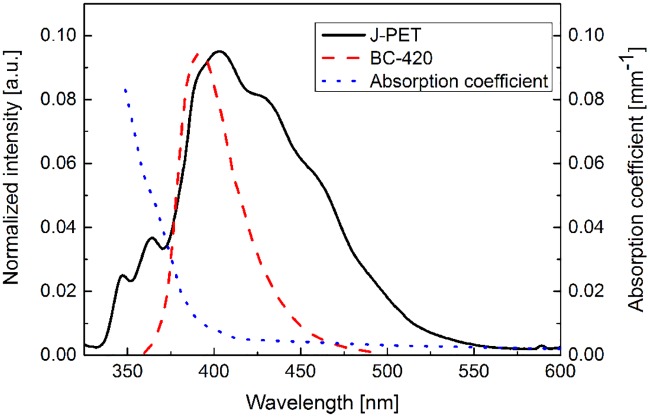
Emission spectra of BC-420, J-PET scintillator and scintillators’ absorption coefficient μeff [37, 38].The emission spectra are normalized in amplitude.